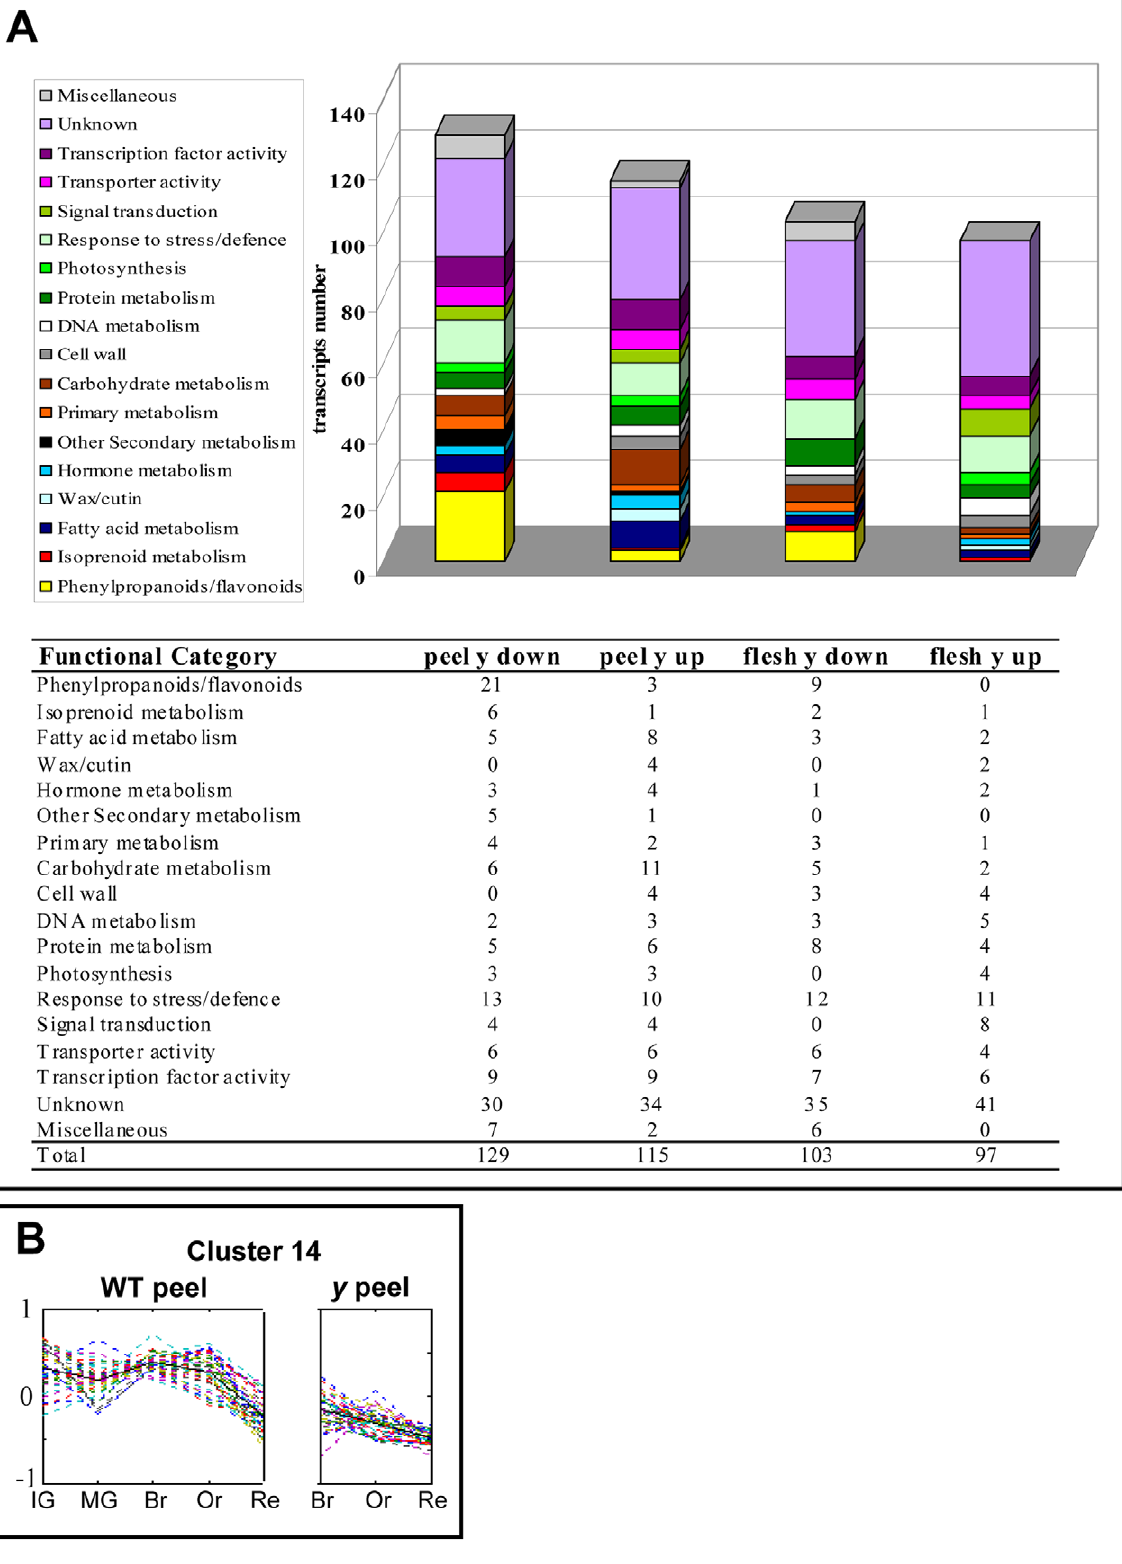
Figure 2. Gene-expression alterations in the y mutant fruit as revealed by array analysis. (A) Functional category distribution among differentially expressed wt and y mutant transcripts at the three latest stages of fruit development. (B) The expression profile (obtained by array analysis) of genes belonging to cluster 14 (total 38 members) in the peel tissue of y mutant and wt fruit. In the y mutant, array analysis was carried out on three of the five stages of fruit development examined in the wt fruit.